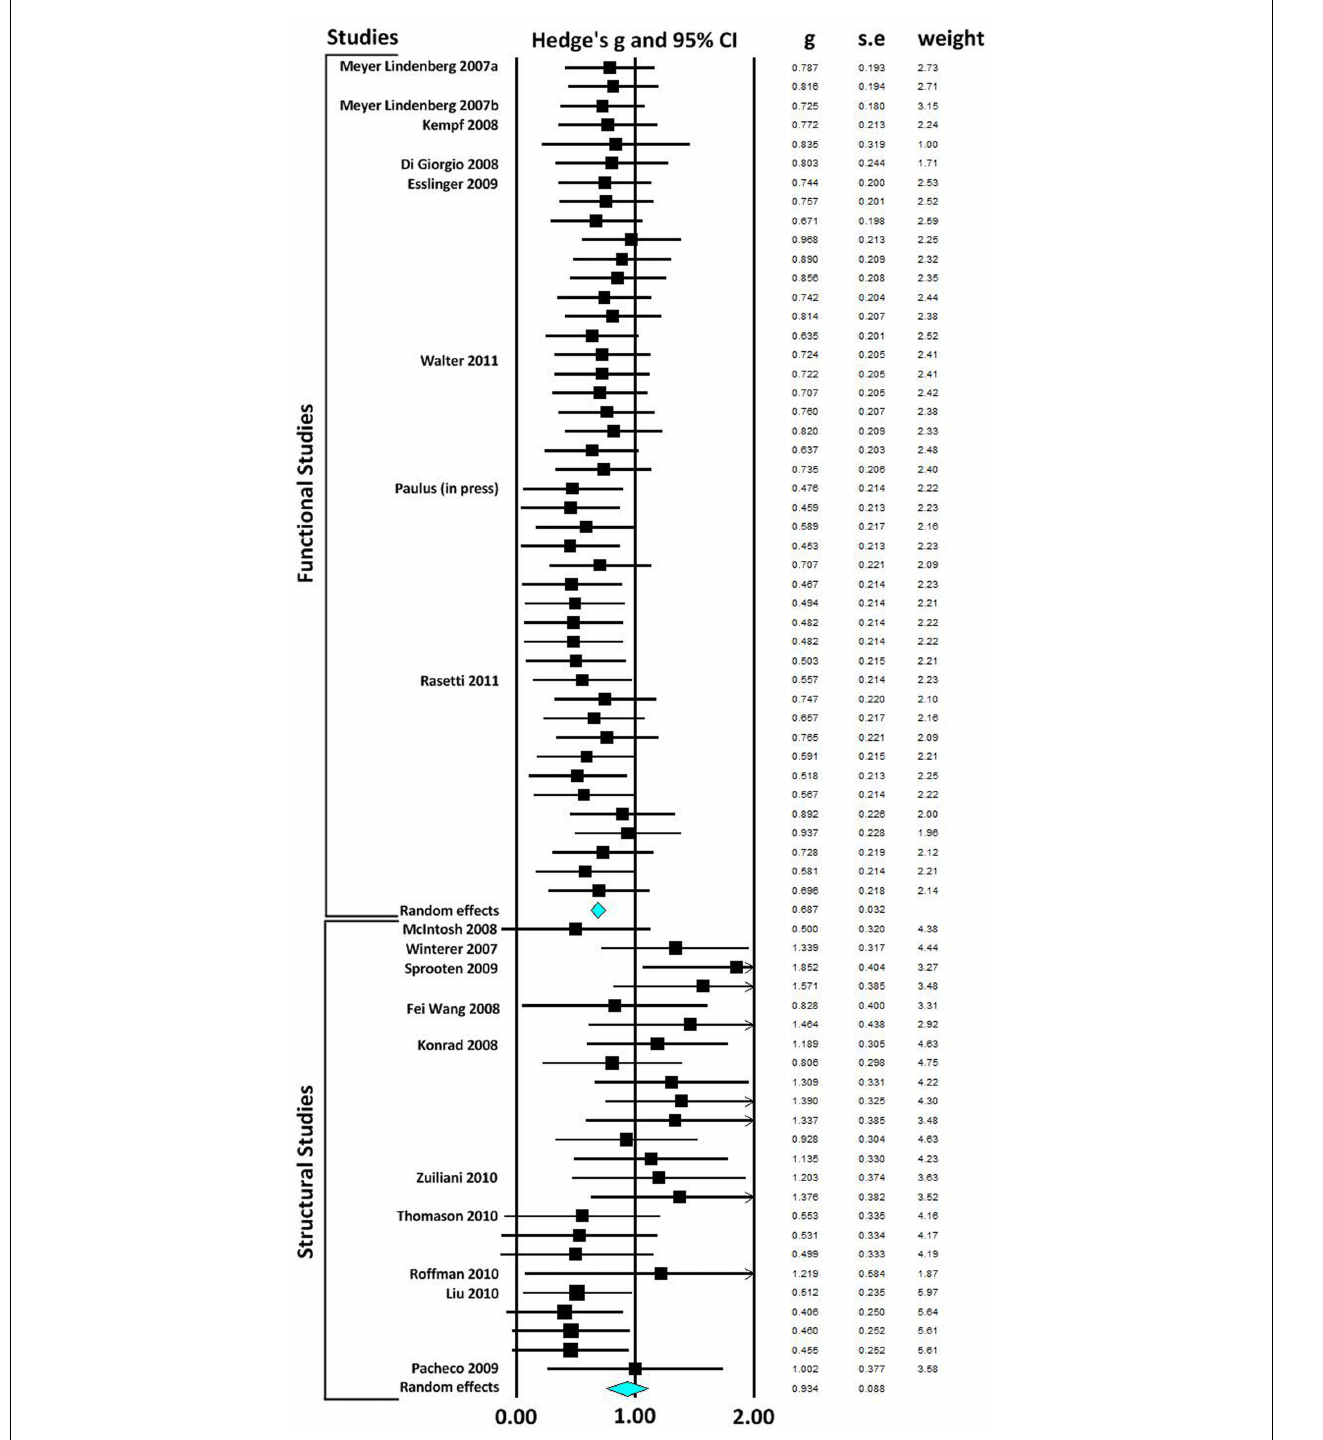
FIGURE 2 | Forest plot reporting Hedges’ g and 95% CI for each functional and structural connectivity analysis. CI, confidence interval; g, Hedges’ g ; SE, standard error.